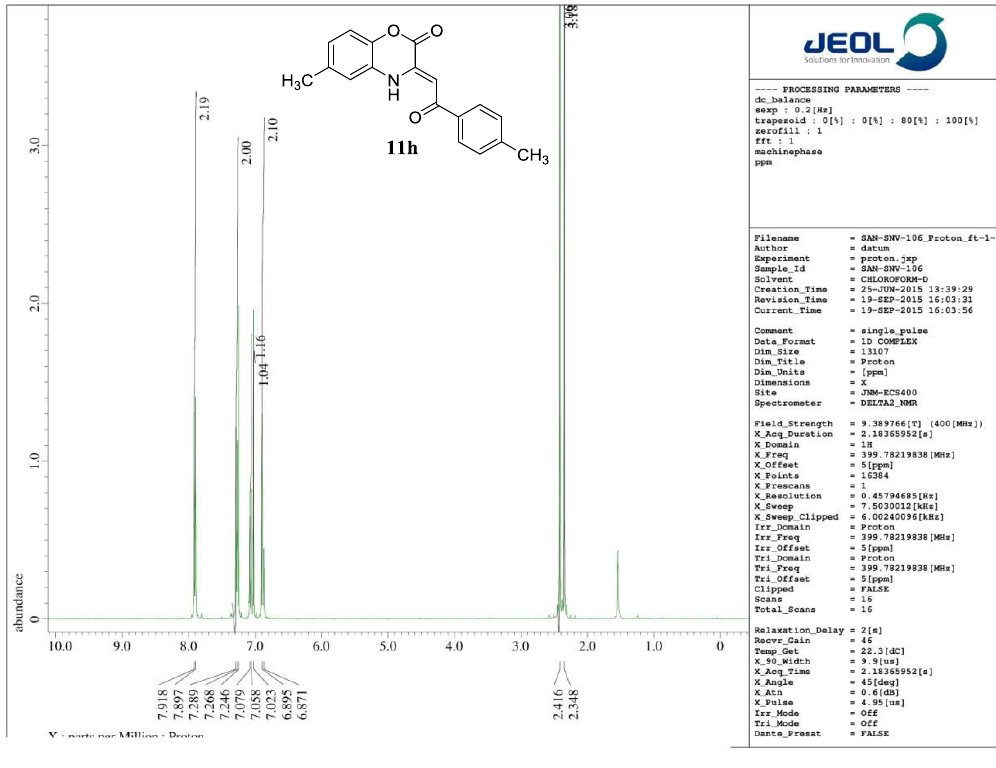
Figure 15. 1 H NMR Spectra of Compound 11h .